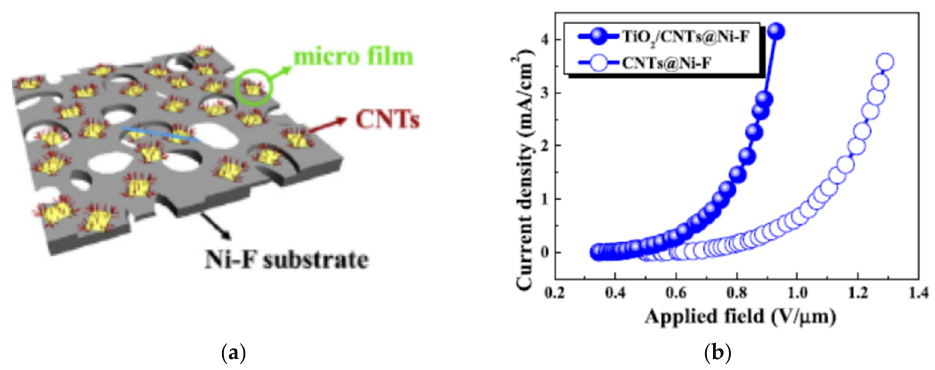
Figure 17. The field-emission enhancement by use of film coating with the material di ff erent from CNTs: ( a ) a schematic illustration of CNT FE cathode on Ni–Fe foam coated with TiO 2 film and ( b ) its FE characteristics with and without TiO 2 film. Reprinted with permission from [34].